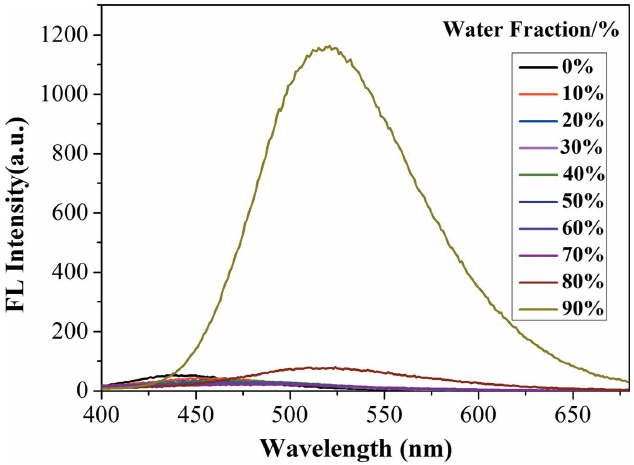
Figure 3 Fluorescence spectra of the title compound in water–THF mixtures with different water